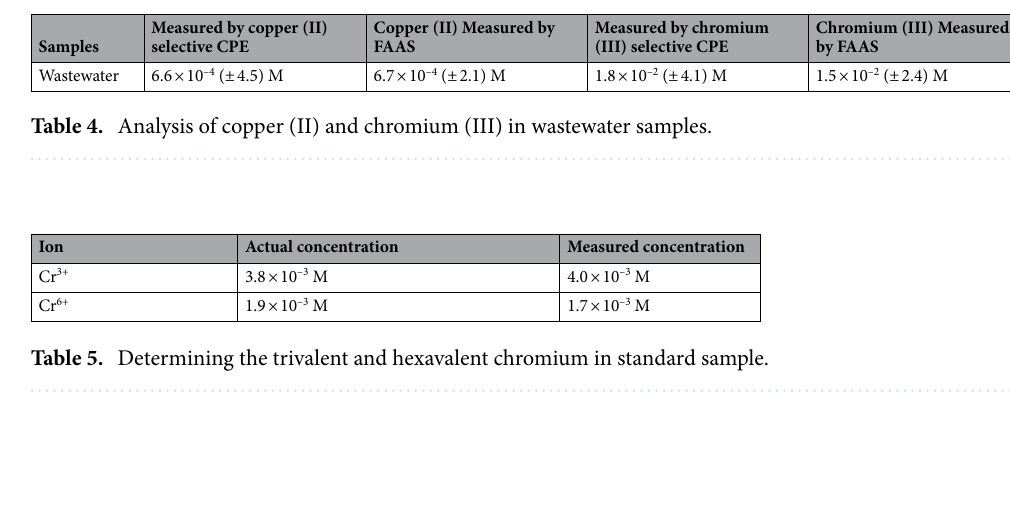
Figure 7. The potential titration curves of 25 mL 1.0 × 10 –4 mol/L analyte solution with 1.0 × 10 –2 mol/L of EDTA by using ( a ) copper (II) and ( b ) chromium (III) selective CPEs.